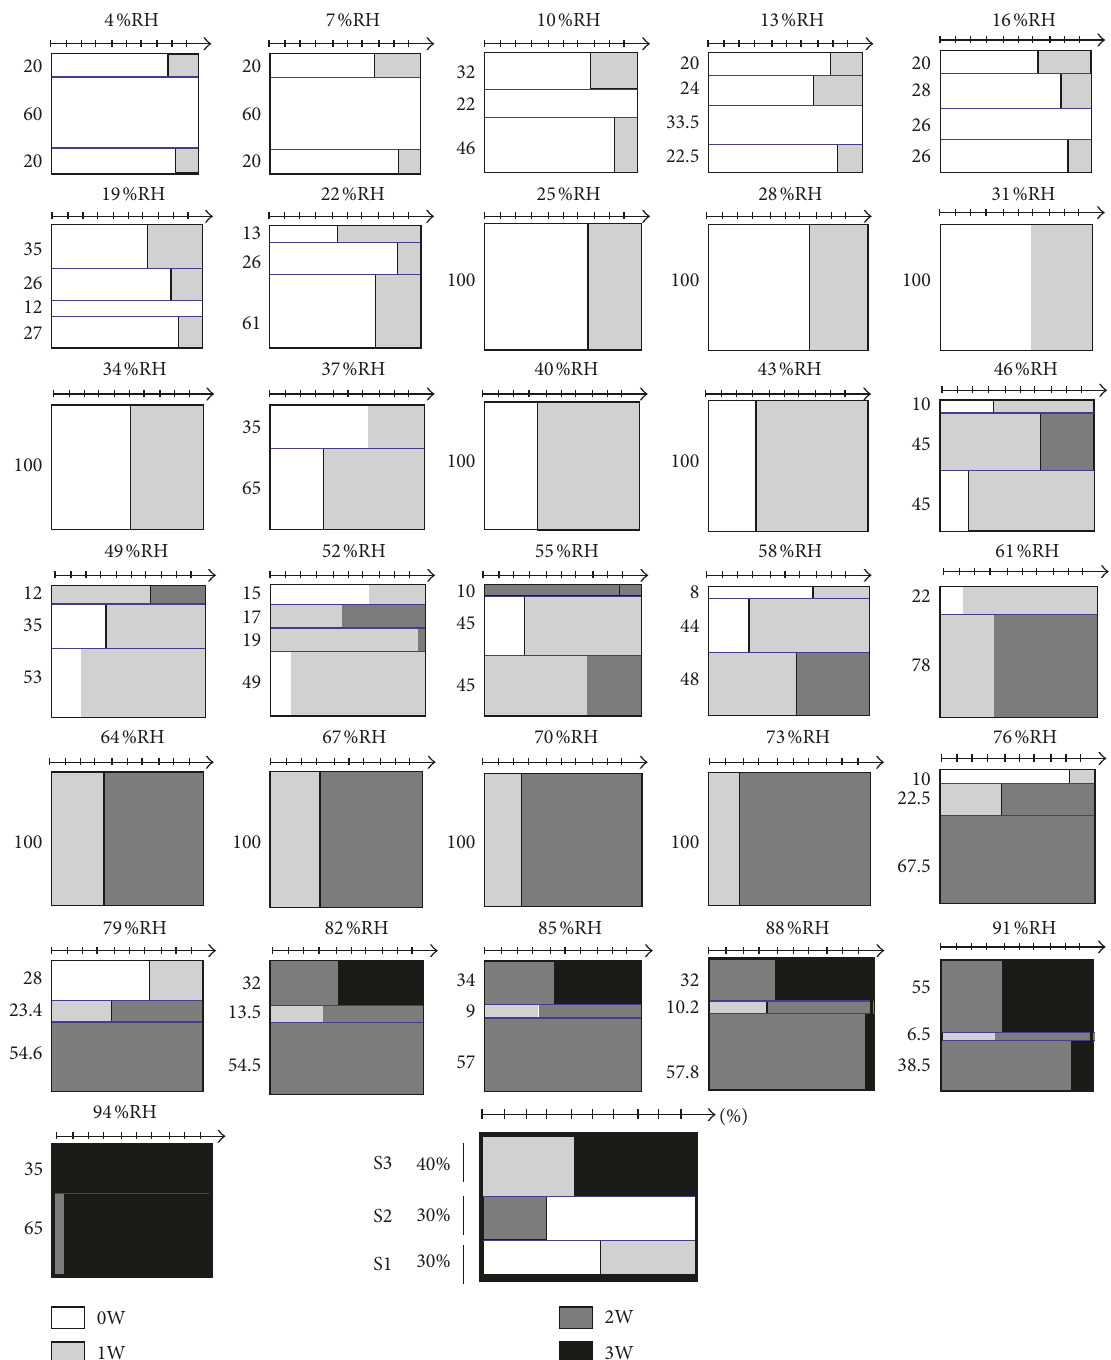
Figure 3: Schematic representation of the structure model used to fit the experimental XRD pattern in the case of the unstressed sample along the sorption process. Relative proportions, expressed in wt.%, of the three elementary mixed-layer structure (MLS) contributions are plotted on the y -axis, whereas their compositions (relative proportions of the different layer types) are plotted on the x